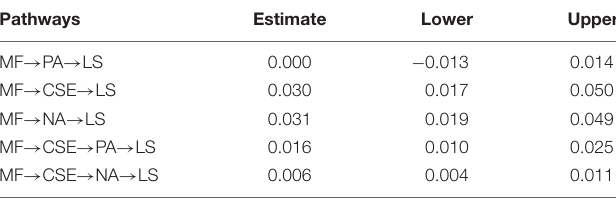
TABLE 3 | Standardized indirect effects and 95% confidence intervals. Pathways